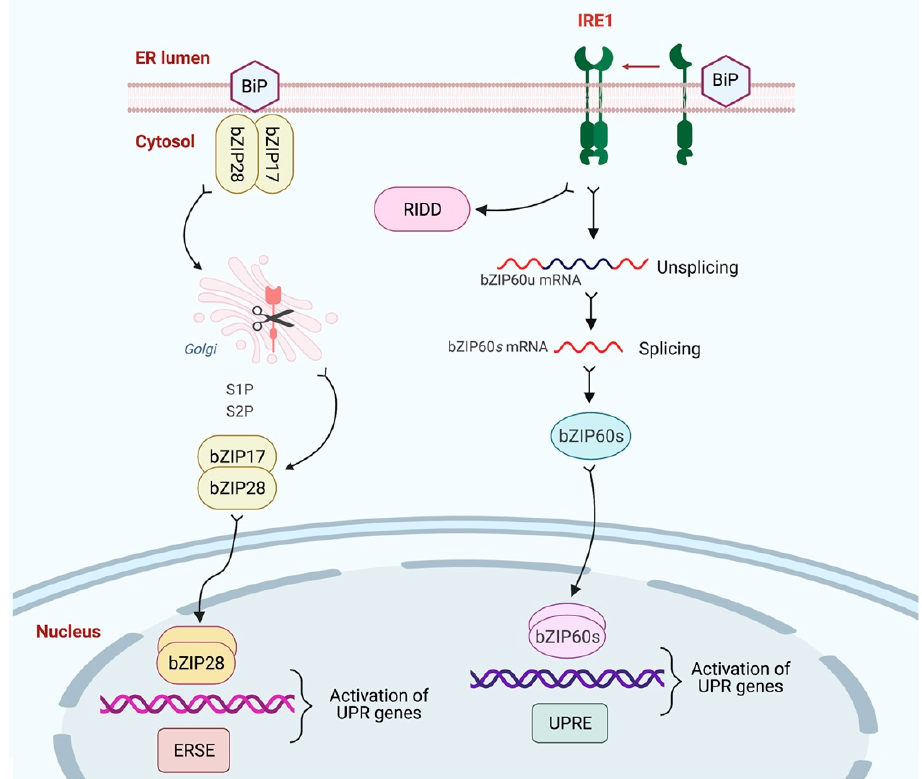
Figure 3. Overview of the pathway for UPR signaling. UPR signaling pathways in plants have two arms/branches. One branch contains the dual protein kinase and ribonuclease, IRE1, responsible for splicing bZIP60 mRNA when activated. The other branch is mediated by bZIP17 and bZIP28, two ER membrane-anchored TFs. A frameshift is introduced by splicing bZIP60(u) mRNA so that the resulting spliced type bZIP60(s) mRNA is translated into a nucleus-targeted TF. In response to ER stress, the bZIP17 and/or bZIP28 are mobilized and transported to the Golgi, where resident site-1 and site-2 proteases process them and release their cytosolic TF domains [bZIP17(p) and/or bZIP28(p)] into the cytoplasm for further importation into the nucleus. The bZIP17(p) and bZIP28(p) can homodimerize or heterodimerize in the nucleus, where they bind to the promoters and regulate the expression of genes that respond to stress. This figure was created using BioRender